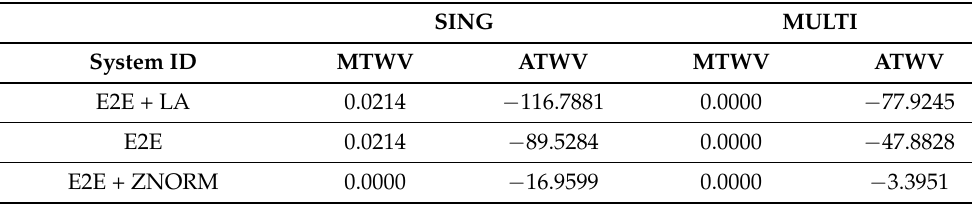
Table 30. System results of the QbE STD task for RTVE test data for single-word (SING) and multi-word (MULTI)